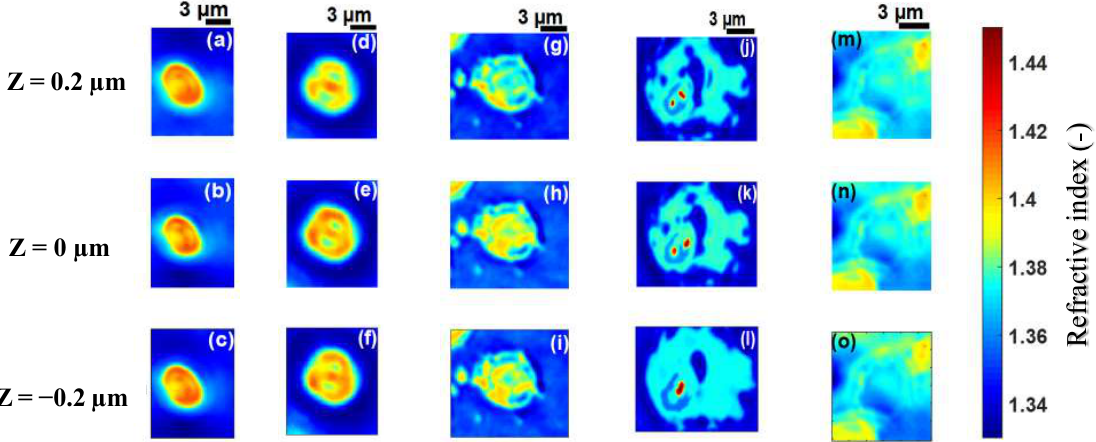
Figure 11. Refractive index distributions within cell A ( a )–( c ), cell B ( d )–( f ), cell C ( g )–( i ), cell D ( j )–( l ), and cell E ( m )–( o ) for different z planes.